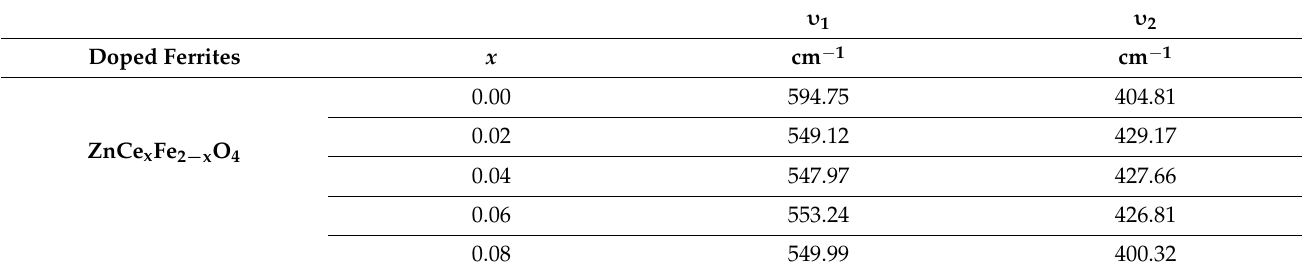
ZnCe x Fe 2 − x O ZnCe x Fe 2 − x O 4